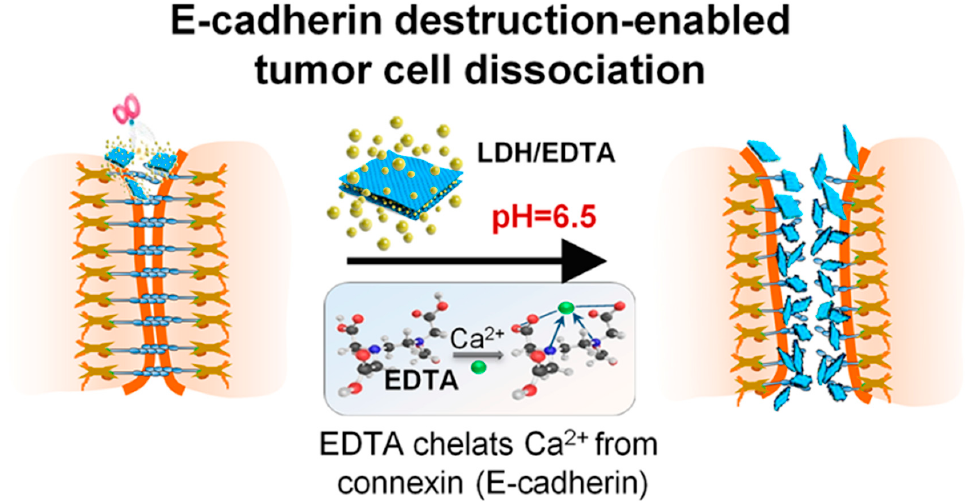
Figure 2. A scheme of tumor cell dissociation induced by E-cadherin pH-responsive nanoparticle in low colorectal tumor. Reprinted with permission from Ref. [20]. Copyright 2022, Shi, J.